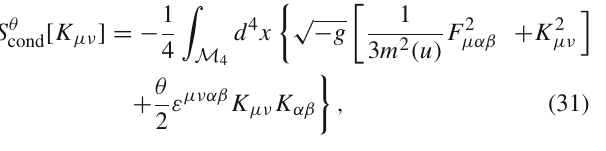
Fig. 6 Real and imaginary parts of the Hall AC conductivity as func- tions the θ -angle and the dimensionless frequency variable, w = 3 ω/ 4 π T , for C (cid:12) = (cid:12) L / 2 = 1 (dimensionless combination involv-